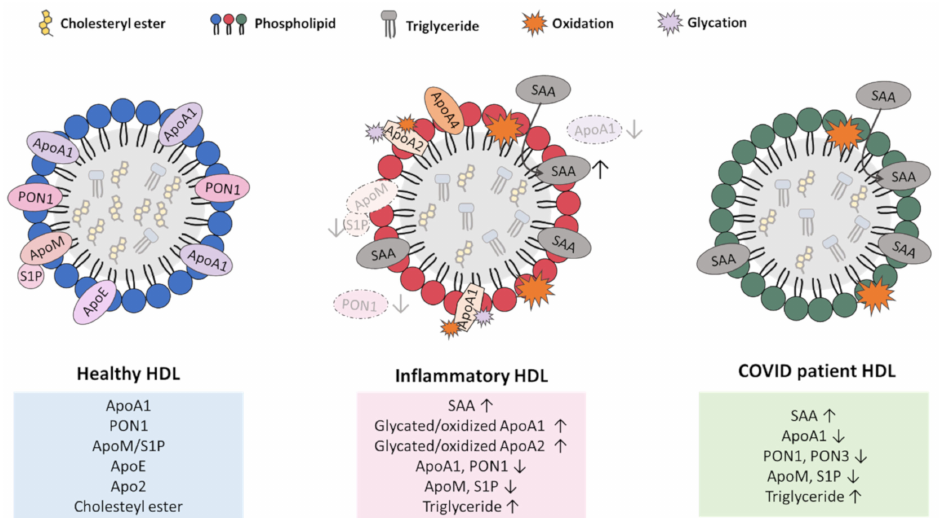
Figure 4. HDL remodeling in inflammatory/cardiometabolic disease and COVID-19. HDL is extensively remodeled during inflammatory and cardiometabolic disease ( center ) and in COVID- 19 patients ( right ). Healthy HDL is shown on the left . Similar changes in HDL in inflammatory and cardiometabolic disease include oxidation and glycation of HDL-associated proteins, including ApoA1; replacement of ApoA1 with serum amyloid A-1 (SAA1); reductions in paraoxonase 1 (PON1), ApoM/sphingosine-1-phosphate (S1P), and ApoE; and increases in core triglycerides. These changes are associated with reductions in the beneficial functions of HDL (anti-oxidant, anti-inflammatory, and anti-cytotoxic properties, as well as cholesterol efflux) and gain of detrimental functions (pro- oxidant, pro-inflammatory, and pro-cytotoxic properties). Similar changes were reported in HDL during COVID-19 disease, suggesting similar changes in HDL particle functions may contribute to disease development. Arrows pointing up represents increase and arrows pointing down represents decrease for respective